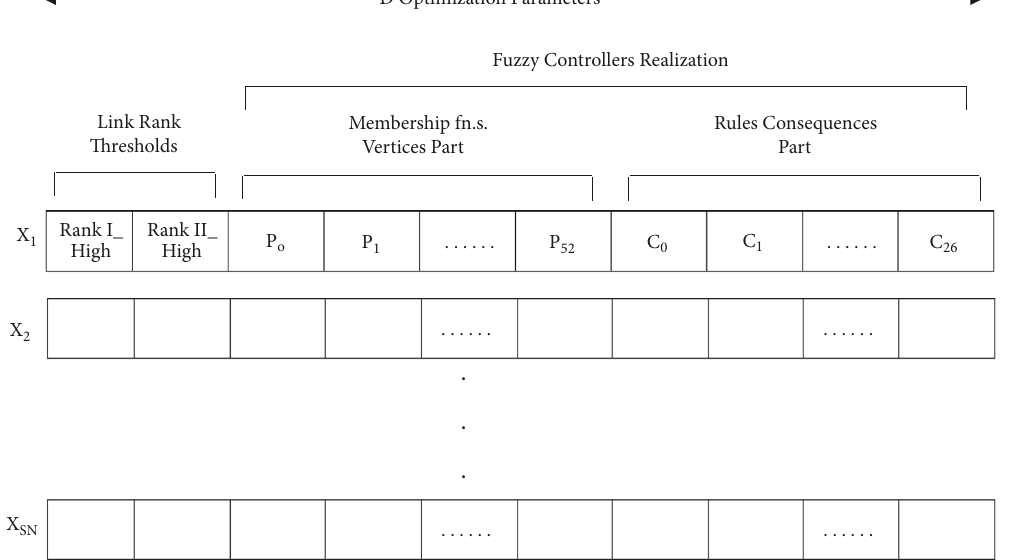
Figure 1: Food sources